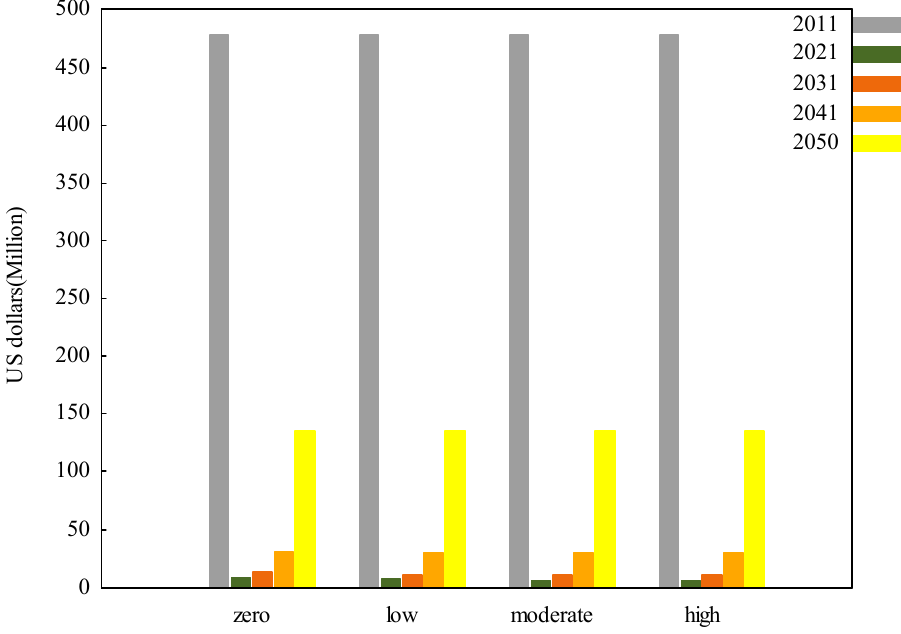
Figure 14. Total social welfare under subsidy action.